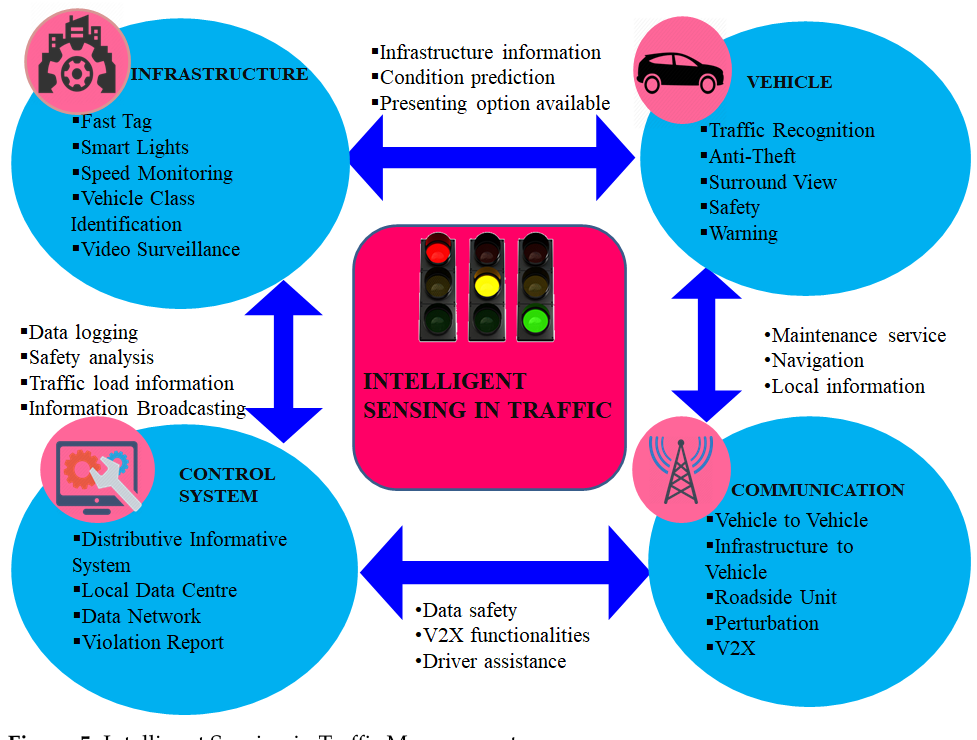
Figure 5. Intelligent Sensing in Traffic Management.